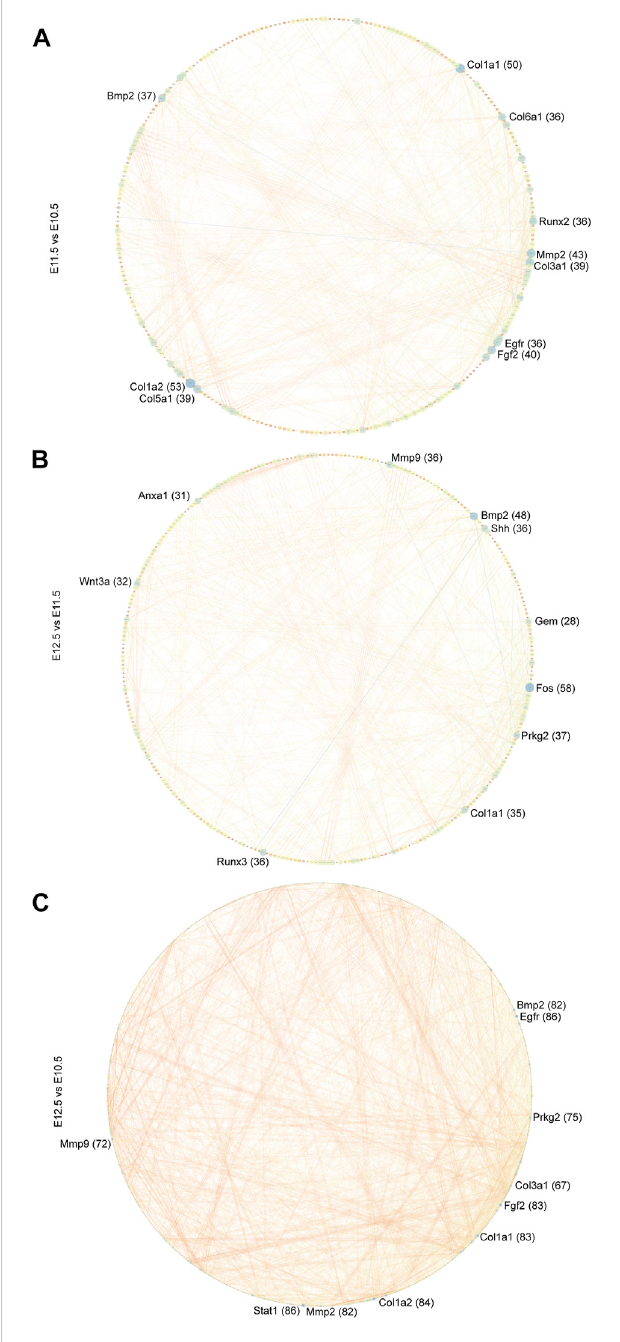
FIGURE 8 PPInetworkofdevelopmentallyrelatedDEGs.PPInetworkofDEGs among comparison groups (A) E11.5 vs. E10.5, (B) E12.5 vs. E11.5, and (C) E12.5 vs. E10.5 constructed in Cytoscape. The top 10 hub nodes (genes) aremarked. The numbersinparenthesesnextto thegenesindicate the node